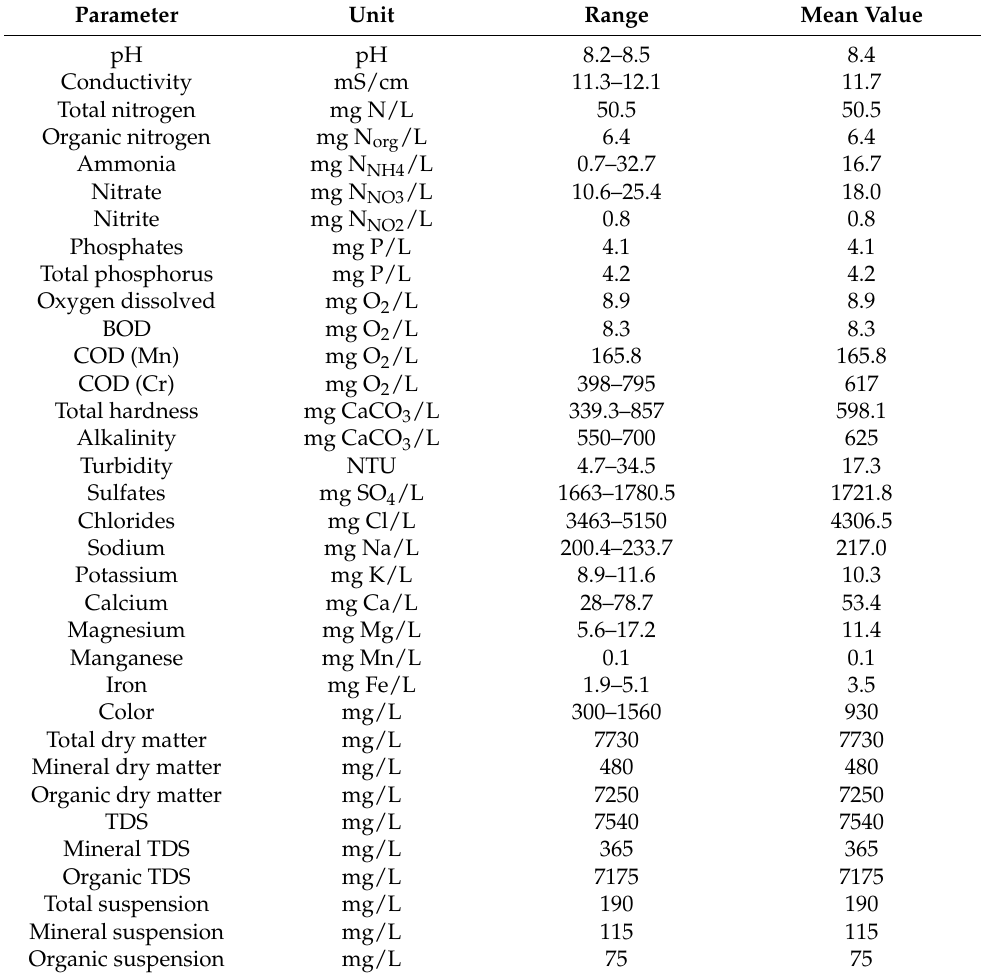
Table 2. The average composition of the stream after the biological treatment and sedimentation pro- cess from a coke plant (the name protected by contract) in Poland (data received from the